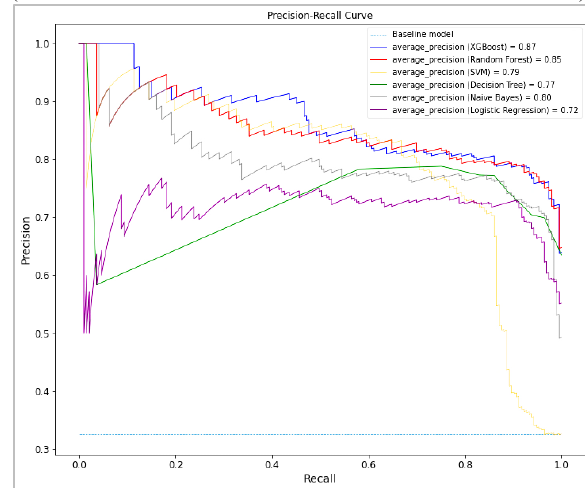
Figure 8. Precision-Recall Curve Analysis with average precision score comparison between used ML algorithms